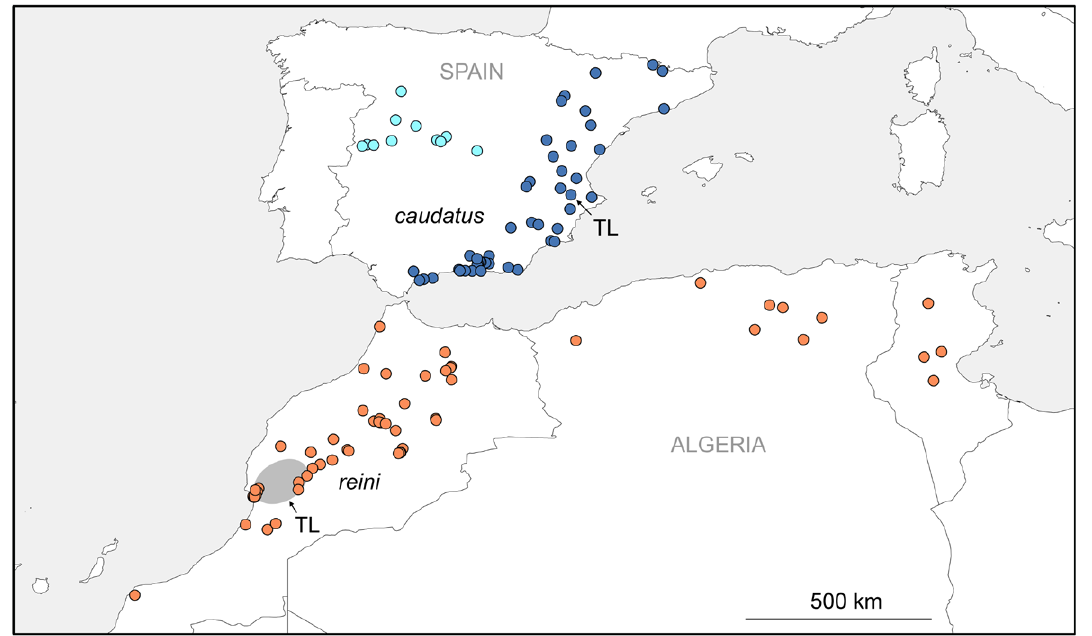
Fig. 3. Known distributions of Holocnemus reini (C. Koch, 1873) comb. nov. and H. caudatus (Dufour, 1820). Light blue: dubious records; see Distribution section for details. Abbreviation: TL = type localities (the type locality of H. reini is not exactly known; see text for details).